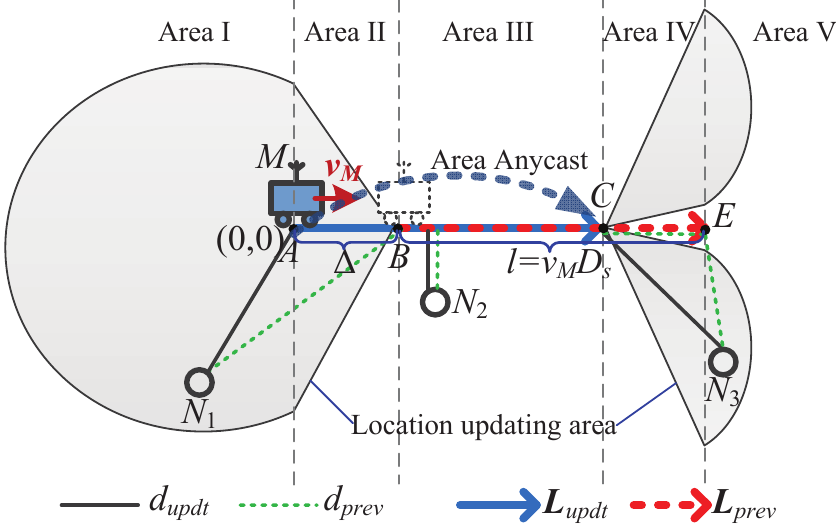
Figure 5. An example of the sink location calibration in